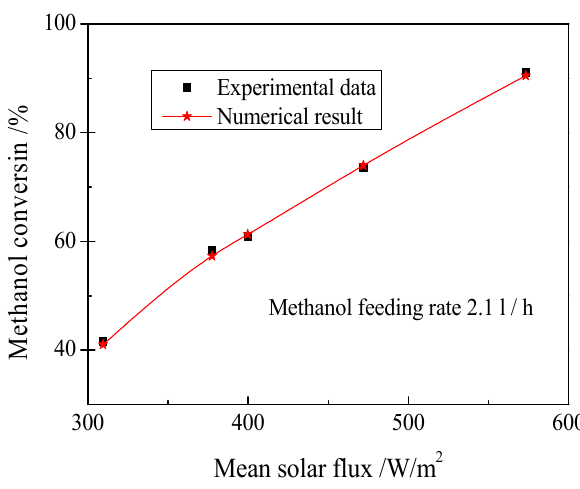
Figure 3. Comparison of the methanol conversion between the numerical model and experiment.